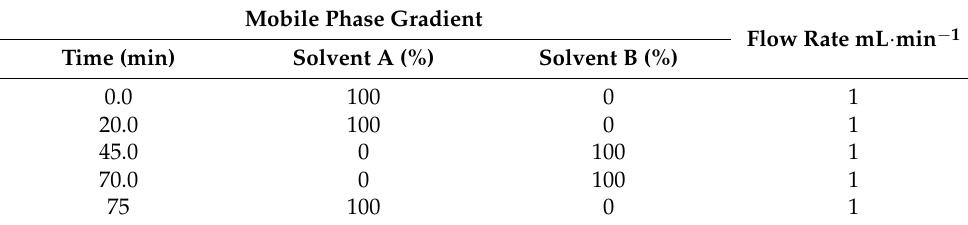
Table 1. Phase gradient used in the HPLC